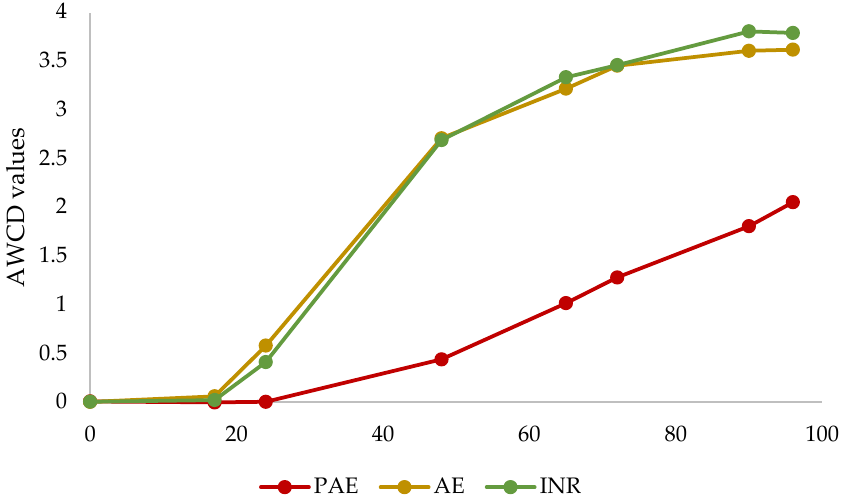
Figure 1. Variation in average well colour development (AWCD) values from 0 to 96 h of incubation in the Integral Natural Reserve (INR), AgroEcosystem (AE), and Polluted AgroEcosystem (PAE).